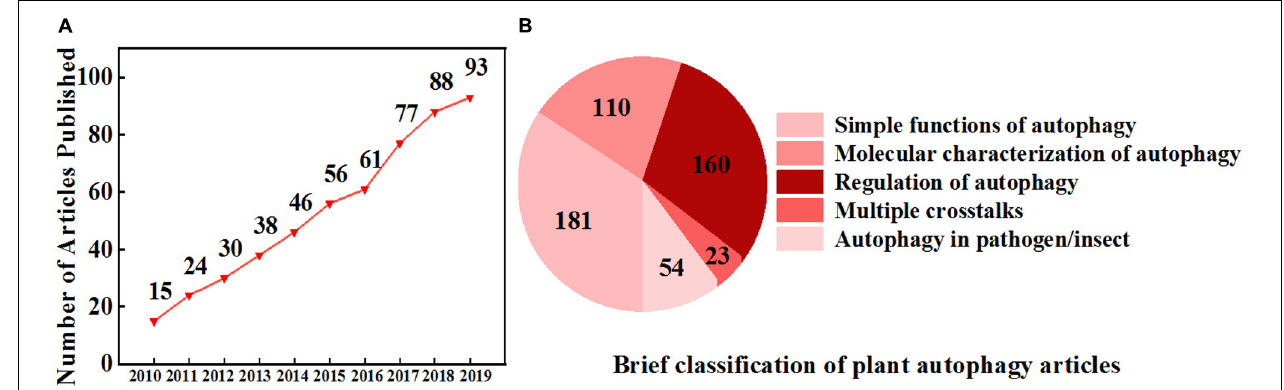
FIGURE 1 | Increasing interest in plant autophagy. (A) The number of research articles published on autophagy in plants from 2010 to 2019. Information was retrieved from the Web of Science with the topic “plant autophagy” refined by the database “Web of Science Core Collection.” (B) A brief classification of plant autophagy articles from 2010 to 2019 based on (A) by manual division.